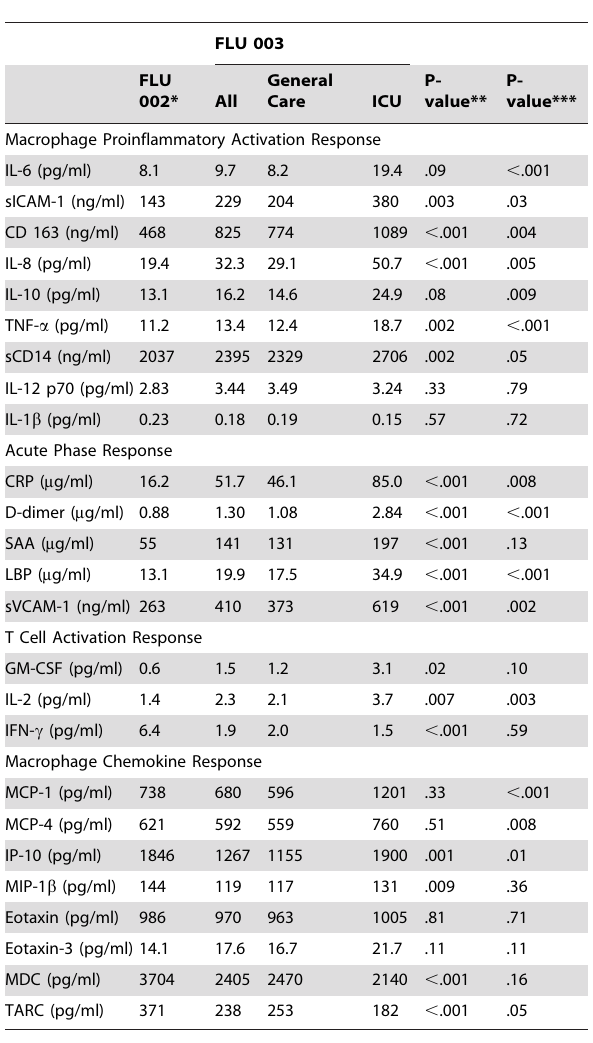
Table 2. Geometric Means of Biomarkers for Patients in FLU 002 and FLU